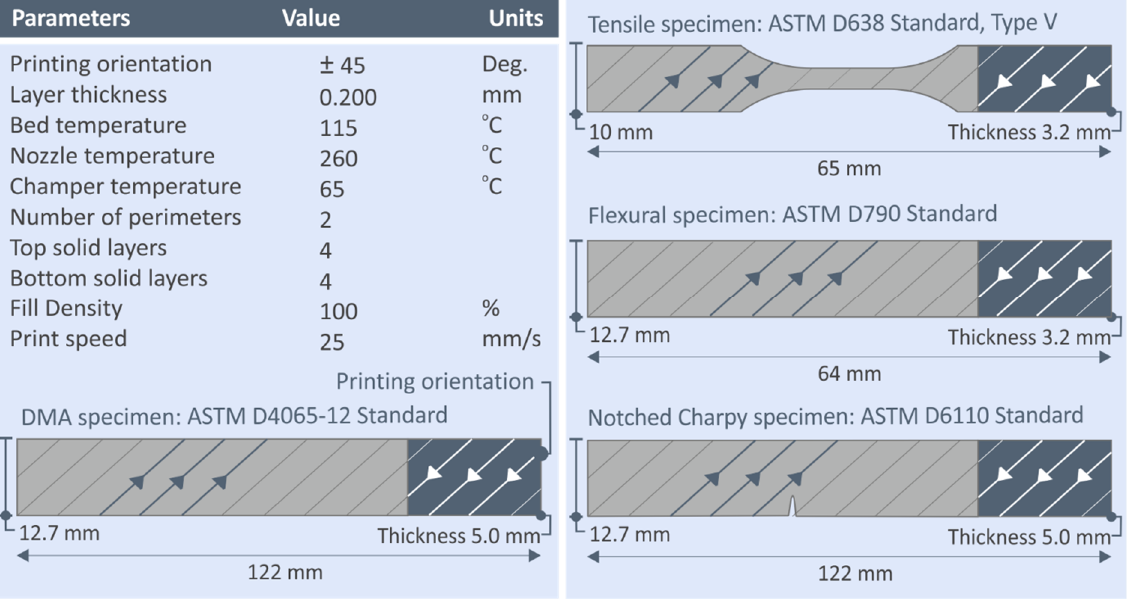
Figure 2. 3D printing settings for manufacturing the specimens of this work. Specimens manufactured are shown on the right side of the figure.